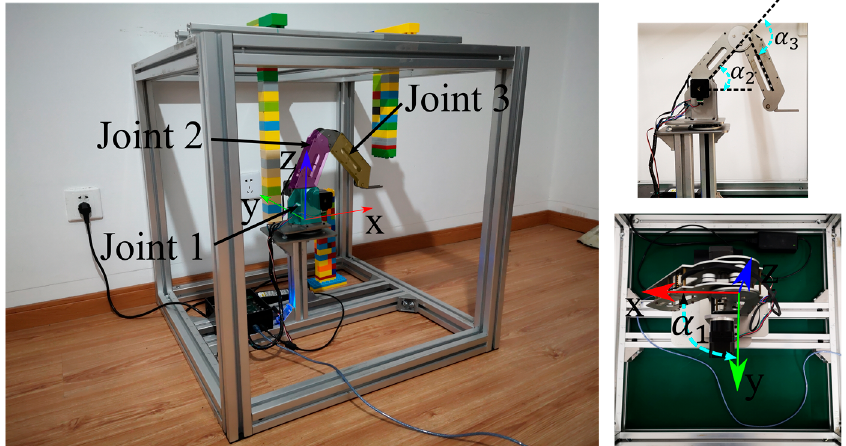
Figure 15. The experimental platform for demonstration